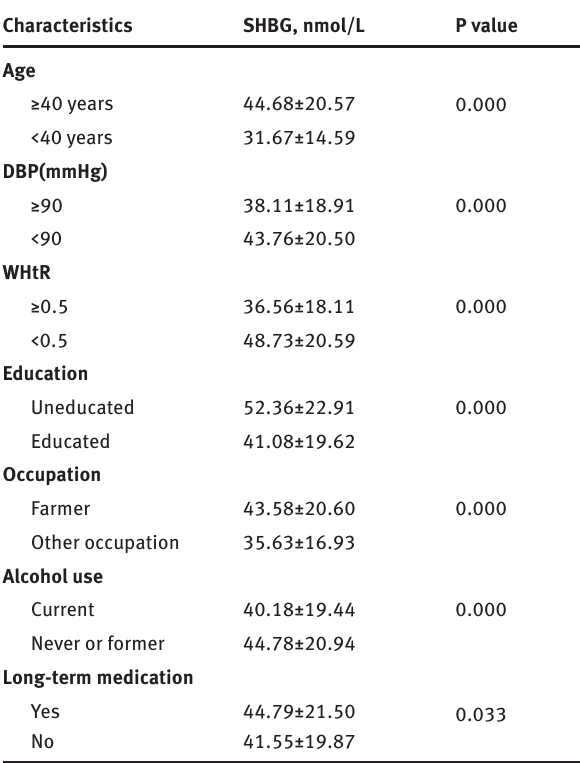
Table 2: Mean SHBG level by demographic characteristics